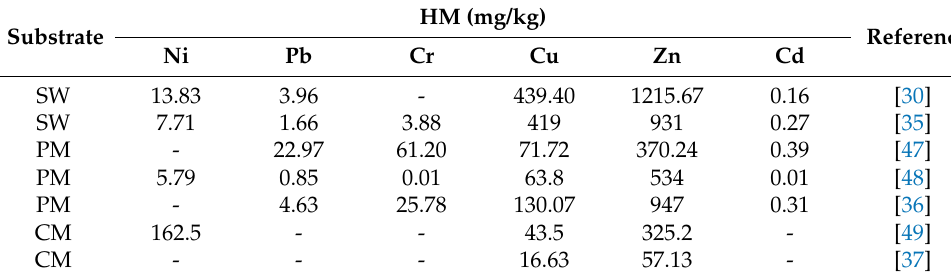
Table 1. Presence of heavy metals (HMs) in biogas digestates.